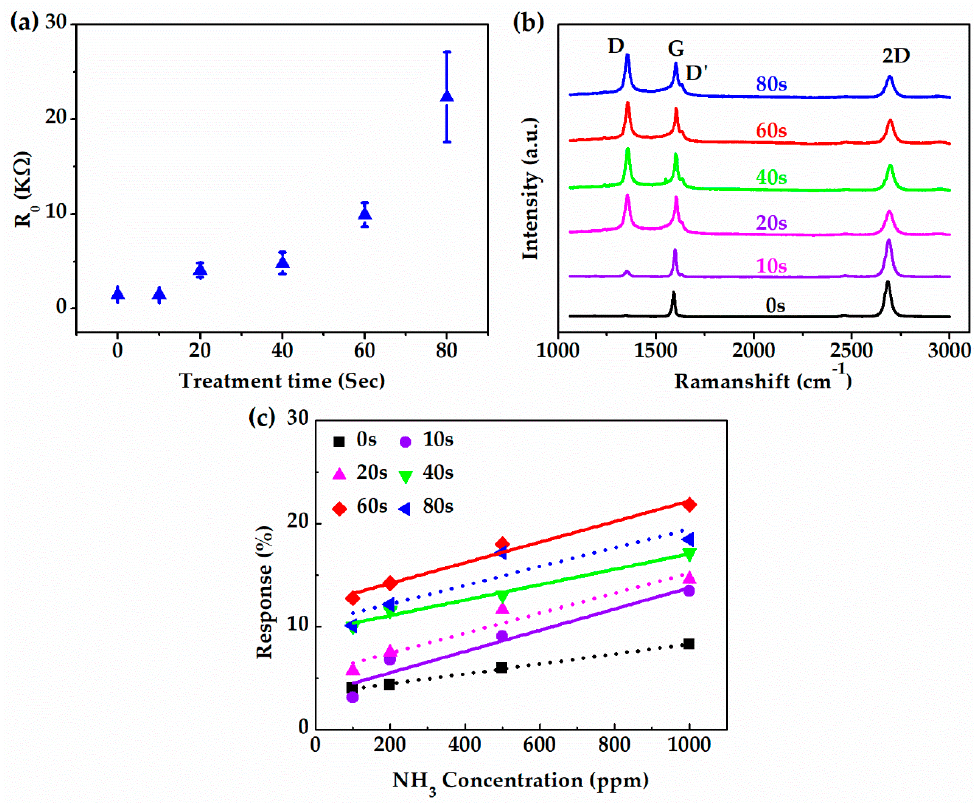
Figure 6. The effect of oxygen plasma treatment time. ( a ) Resistance and ( b ) Raman spectra of OP-G with different treatment time. ( c ) Sensitivity of OP-G with different treatment time towards different concentrations of NH 3 .